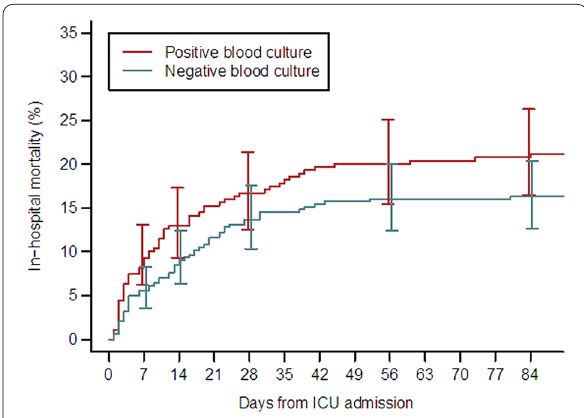
Fig. 1 Probability of hospital mortality according to blood culture result ( p =